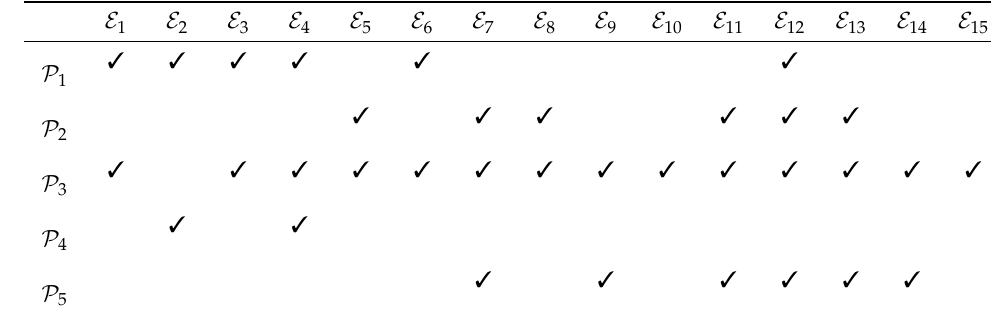
Figure 1. Evaporation equipment: ( a ) An evaporation plant scheme; ( b ) Cooling system layout. This efficiency is reflected in the live steam (resource) that each plant needs to consume in order to achieve the assigned evaporation set point. Therefore, optimal operation of the cooling systems is key for resource efficiency in the evaporation network. In addition, not all plants can process the spinbaths from the different products, mainly because not all connections from plants to products are physically feasible. Table 1 shows the available links between products and plants, where the ticks indicate that a link is feasible. In total, from 75 possible combinations, only 34 are feasible. From now on, such a set of feasible connections will be denoted by C . Table 1. Connections ( C ) between products ( P ) and evaporation plants ( E ). The ticks indicate feasible